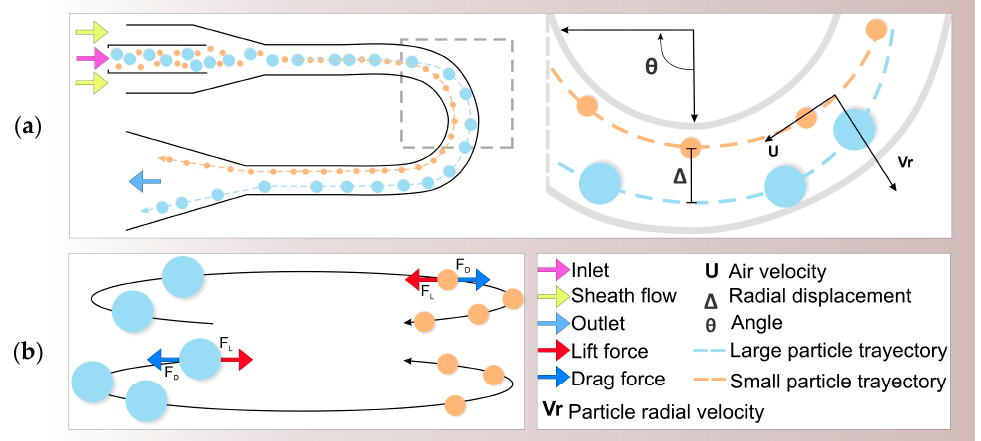
Figure 2. Schematic diagram of the inertial separation principle in a curved microchannel for airborne particle classification. ( a ) Particles mode radially outward in the curved channel due to centrifugal force after their alignment through the application of a sheath flow. ( b ) Dean vortices in a transverse view of the microchannel affecting particle movement.